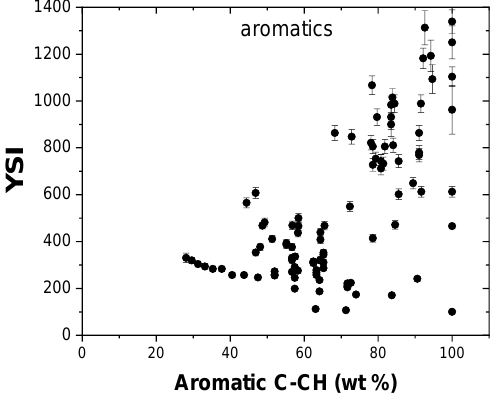
Figure 8. Effect of aromatic C-CH groups on YSI .